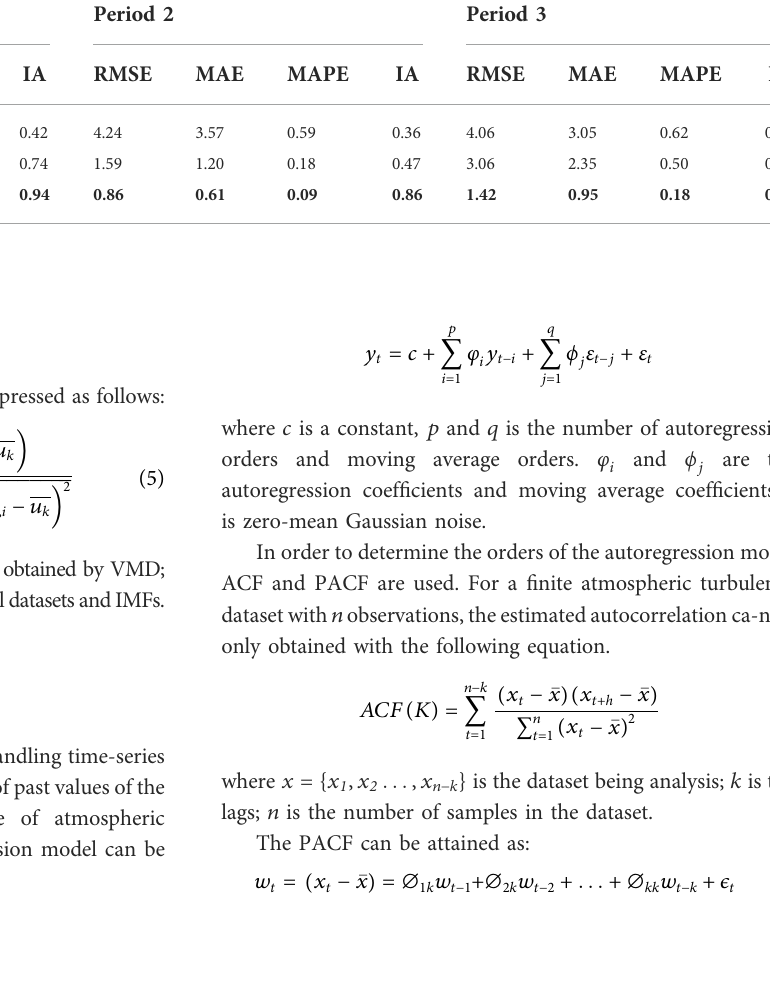
TABLE 2 Performance evaluations of different models for period 1 – 3. Models